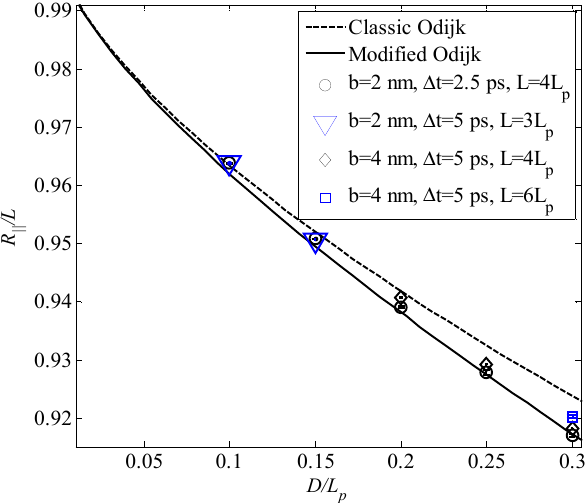
Figure 4. Average extension of the confined WLC without stretching as a function of the ratio D / L p .